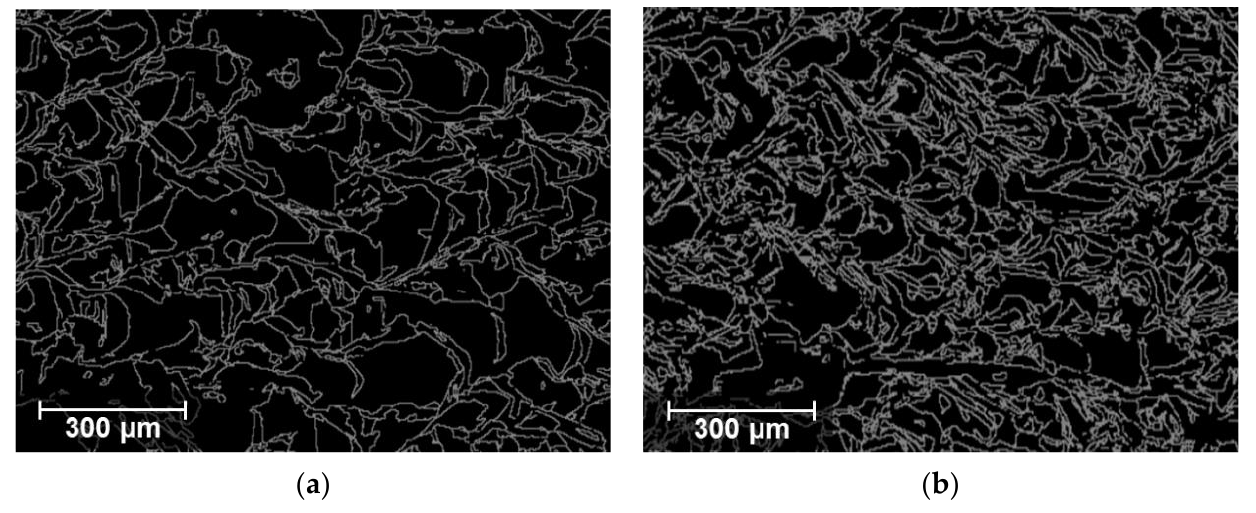
Figure 10. Grain-boundary maps obtained using EBSD for the ( a ) 0.92 m/s and ( b ) 1.16 m/s LBS conditions.